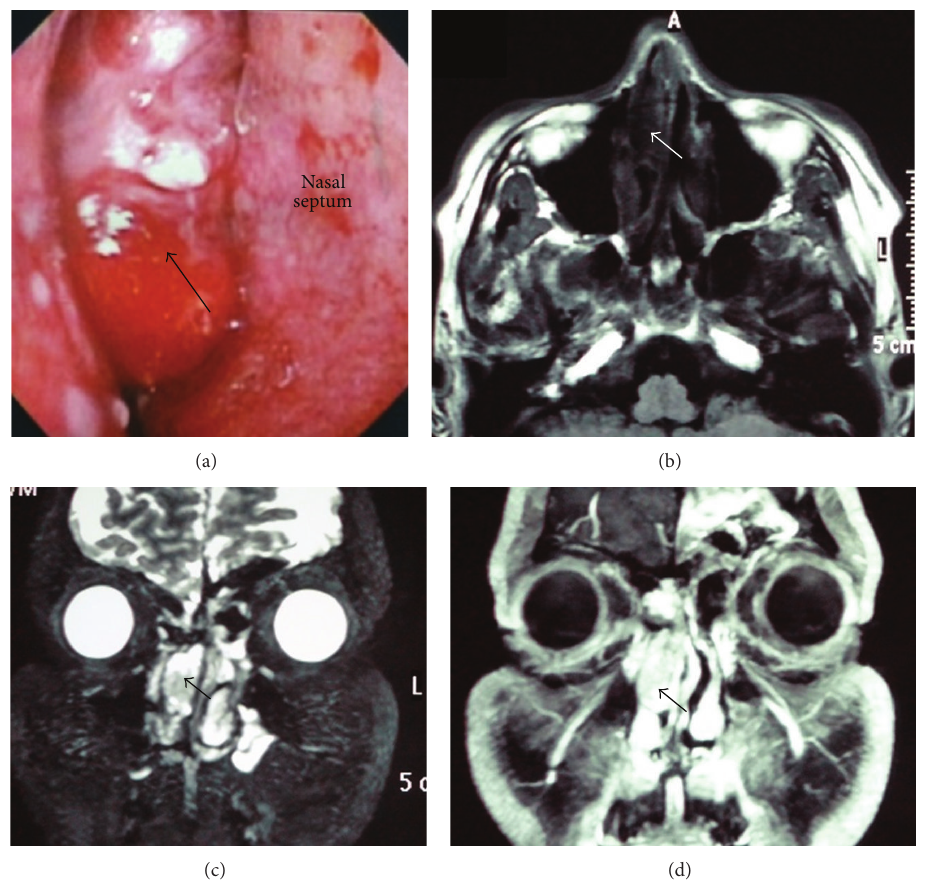
Figure 1: Preoperative local finding and MRI in case 1. (a) Tumor in the right nasal cavity (black arrow). (b) T1-weighted axial image showing low-intensity mass (white arrow). (c) T2-weighted coronal image showing a heterogeneous-intensity mass (black arrow). (d) T1-weighted coronal image (gadolinium+) showing contrast enhancement (black